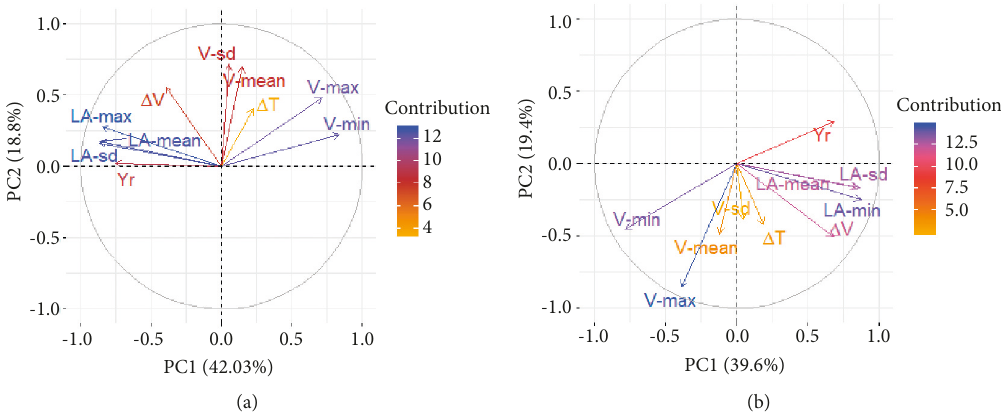
Figure 4: Correlation circles for (a) acceleration maneuvers (b) braking maneuvers. Table 3: Varimax rotated loadings of acceleration and braking datasets. Note: RC stands for rotated components. RC loadings of acceleration maneuvers RC loadings of braking